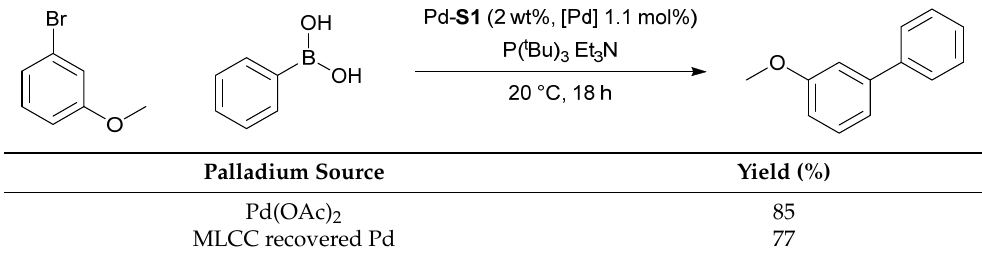
Table 2. Catalytic activity of recovered micellar Pd catalyst, Reproduced with permis ‐ sion from [98].